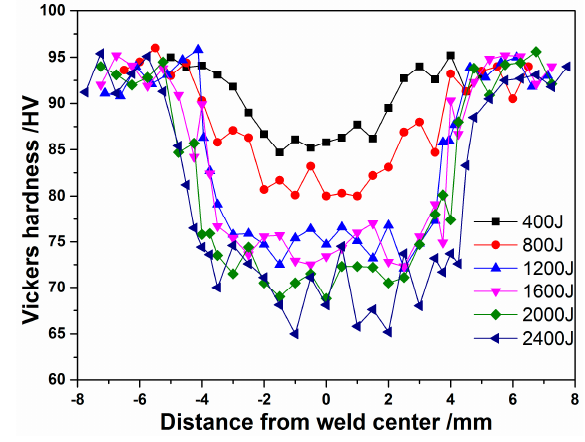
Figure 10. Hardness distributions on the transverse weld zone of the joints with various weld energy